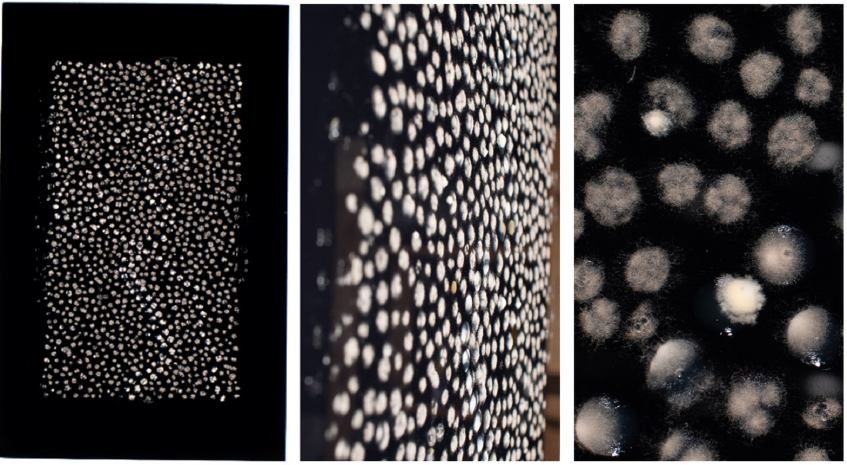
Figure 2. Pilot fungal dot painting on black acrylic glass. A total of 10 5 conidia/mL were suspended in molten YAG agar at 50–55 °C, point inoculated on black acrylic glass (50 × 70 cm) at 50 µL agar volume to generate the prominent dots or at 30 µL agar volume to generate the weaker background volume to generate the prominent dots or at 30 µ L agar volume to generate the weaker background dots. The glass was incubated for 48 h at 37 °C in a humid box. A close-up photograph of the dots dots. The glass was incubated for 48 h at 37 ◦ C in a humid box. A close-up photograph of the dots (right panel) reveals their heterogeneous mycelial density and texture. (right panel) reveals their heterogeneous mycelial density and